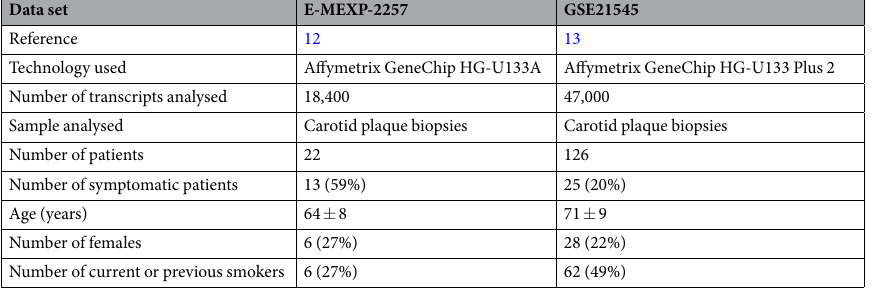
Table 1. Characteristics of two microarray datasets included in this study. Age, calendar age at entry-to-study presented as mean ± standard deviation (SD).